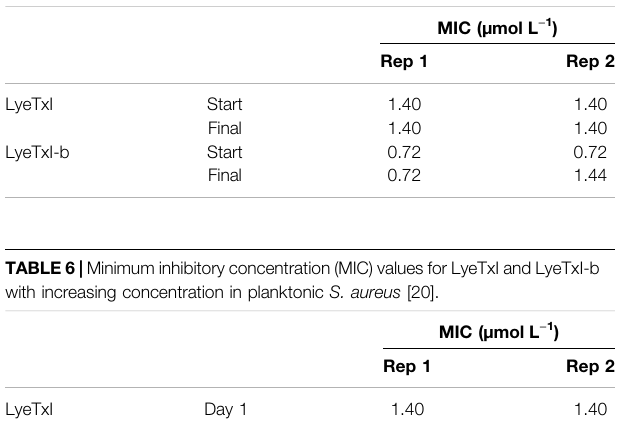
TABLE 5 | Minimum inhibitory concentration (MIC) values for LyeTxI and LyeTxI-b with sub-MIC for 20 days in planktonic S. aureus [20].